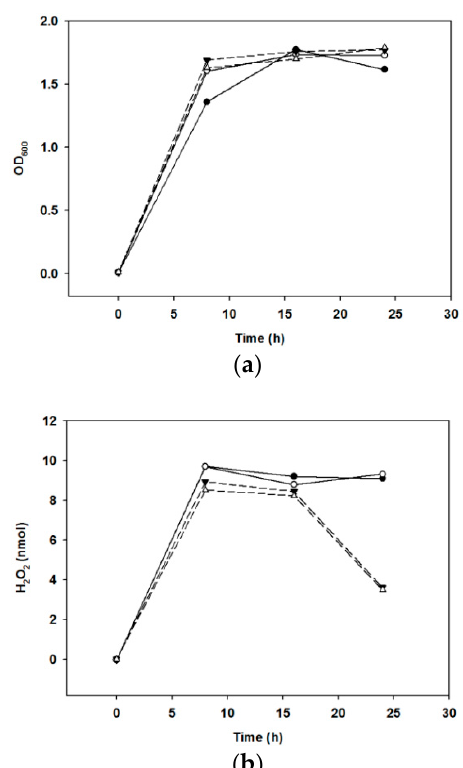
Figure 3. Growth and H 2 O 2 production under various conditions. ( a ) Growth was monitored spectrophotometrically at 600 nm. ( b ) Production of H 2 O 2 , determined as mentioned in Section 4. Solid lines, aerobic incubation at 30 °C ( ● ) and at 37 °C ( ○ ); broken lines, anaerobic incubation at 30 °C ( ▼ ) and at 37 °C ( △ ).